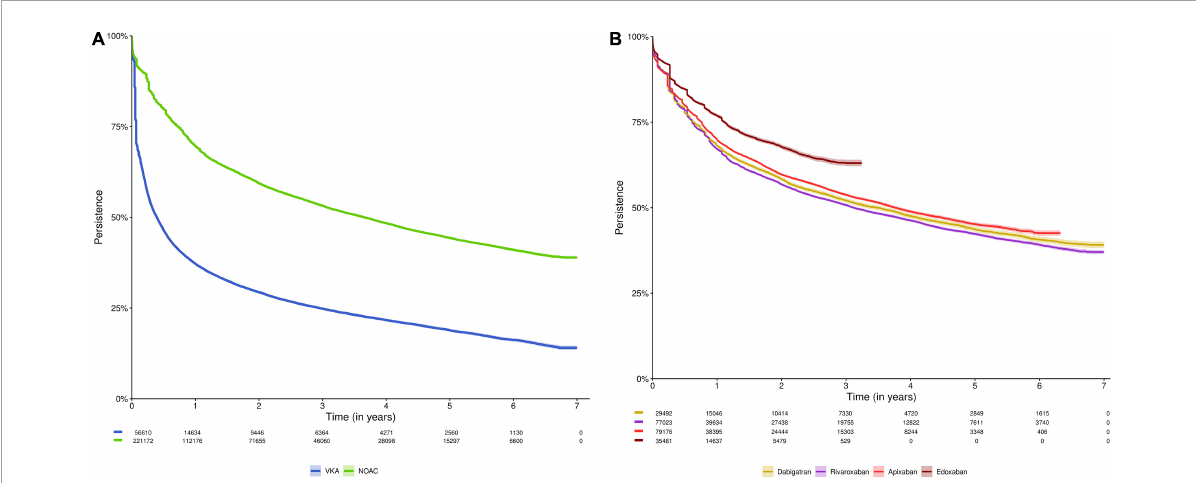
FIGURE2 Kaplan-Meier analysis of persistence to (A) NOACs versus VKAs; and (B) NOAC types (dabigatran, rivaroxaban, apixaban, and edoxaban). Data shown as Kaplan-Meier estimates with 95% confidence interval and risk table (number of patients at risk). In analysis (A) , subjects were censored in case of switching from NOACs to VKAs or vice versa (allowing switching between NOAC types or between VKA types), death, emigration, or end of the study period. In analysis (B) , subjects were censored in case of switching to any other OAC type, death, emigration, or end of the study period. Due to their respective approval in September 2013 and October 2016, and the study period ending on December 31st, 2019, the maximum follow-up duration of apixaban and edoxaban users was limited to 6.3 years and 3.25 years, respectively. NOAC, non-vitamin K antagonist oral anticoagulant; OAC, oral anticoagulant; VKA, vitamin K antagonist.